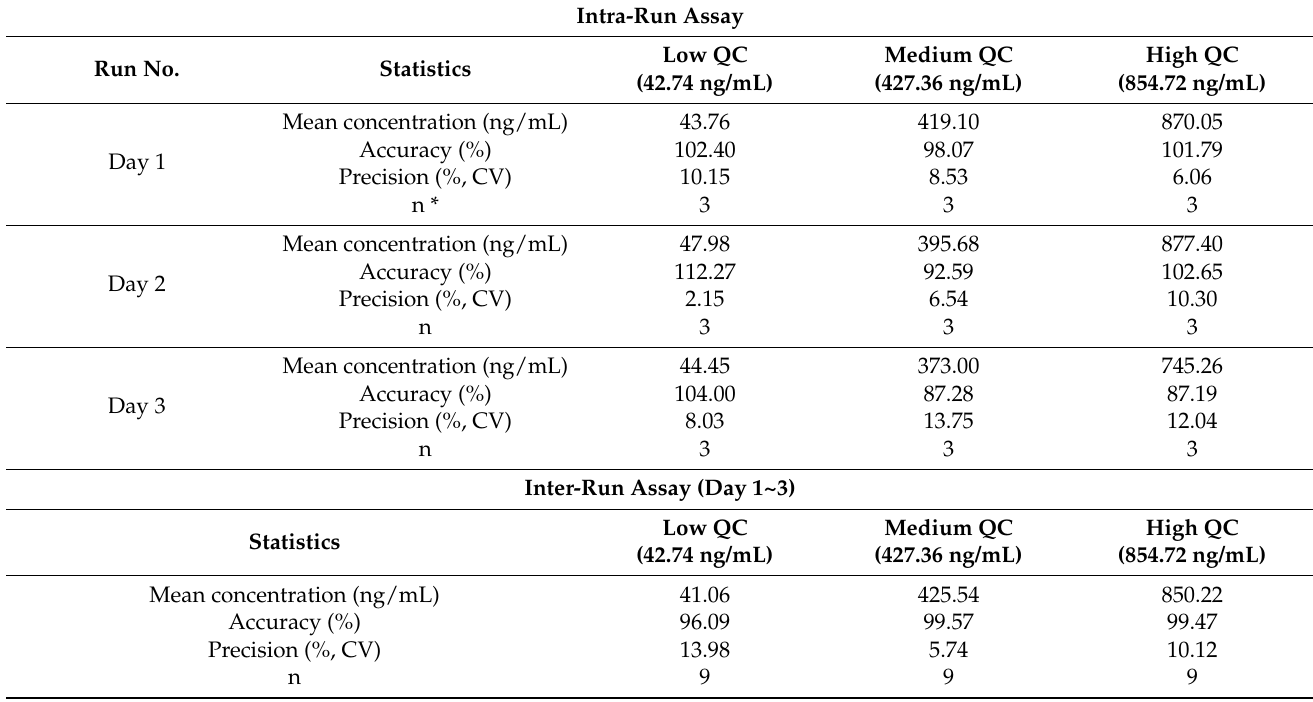
Table 2. The intra/inter-run assays for QC samples of desulfurated DM1. Intra-Run Assay